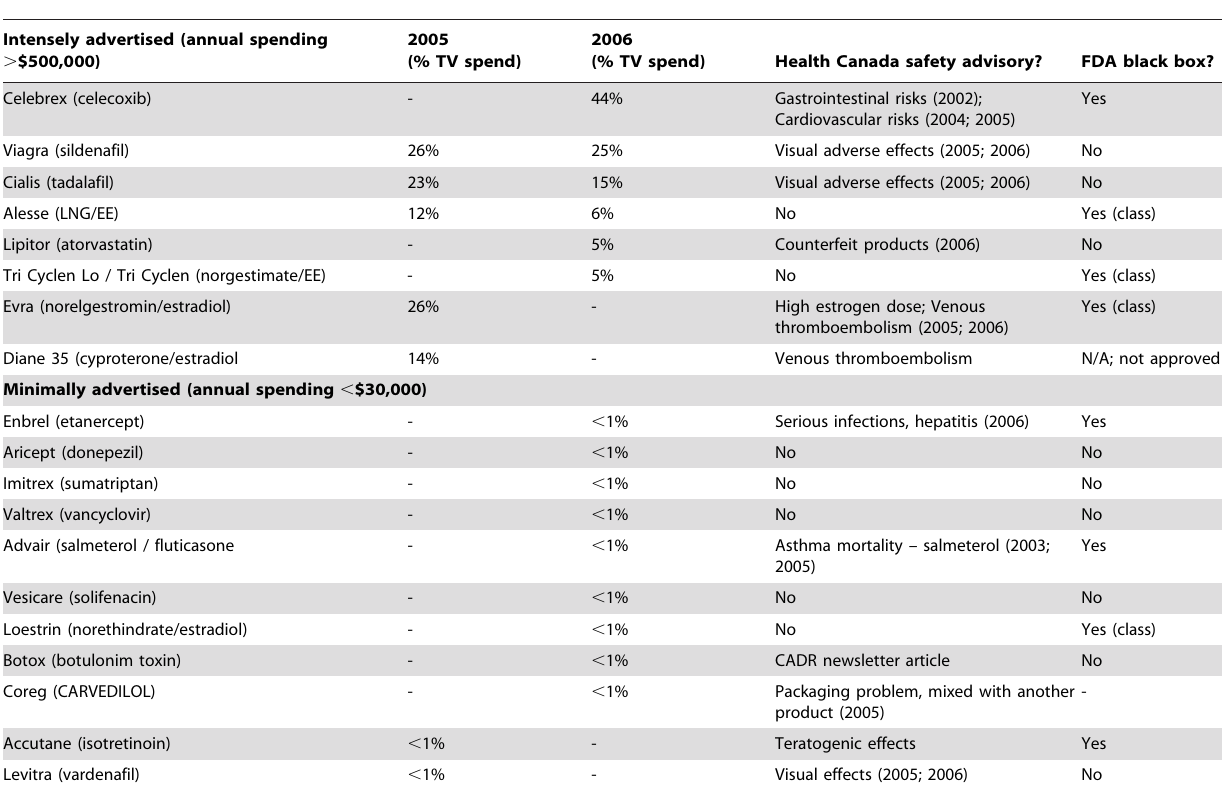
Table 3. Safety advisories and black box warnings: products advertised on television, 2005 and